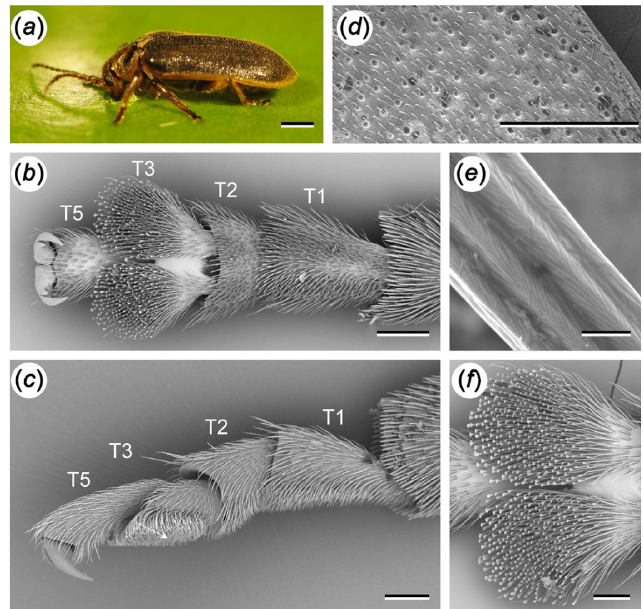
Figure 1. Appearance and tarsal attachment organs of adult G. nymphaeae . ( a ) G. nymphaeae on the water-lily surface. ( b ) Tarsus, ventral. ( c ) Tarsus, lateral. ( d ) Elytra. ( e ) Hair coverage on the elytra. ( f ) Third tarsal segment, ventral. ( d – f ) SEM images. T1–T5: Tarsal segments; T4 is reduced. Scale bars: ( a ) = 1 mm; ( b , c ) = 100 µm; ( d ) = 500 µm; ( e ) = 1 µm, ( f ) = 50 µm. ( a ) Courtesy of Andreas Blankenstein. ( b , c , f ) Reprinted with permission from ref. [15]. Copyright The Authors of the ref. [15] under the license of Company of Biologists Publication Agreement.